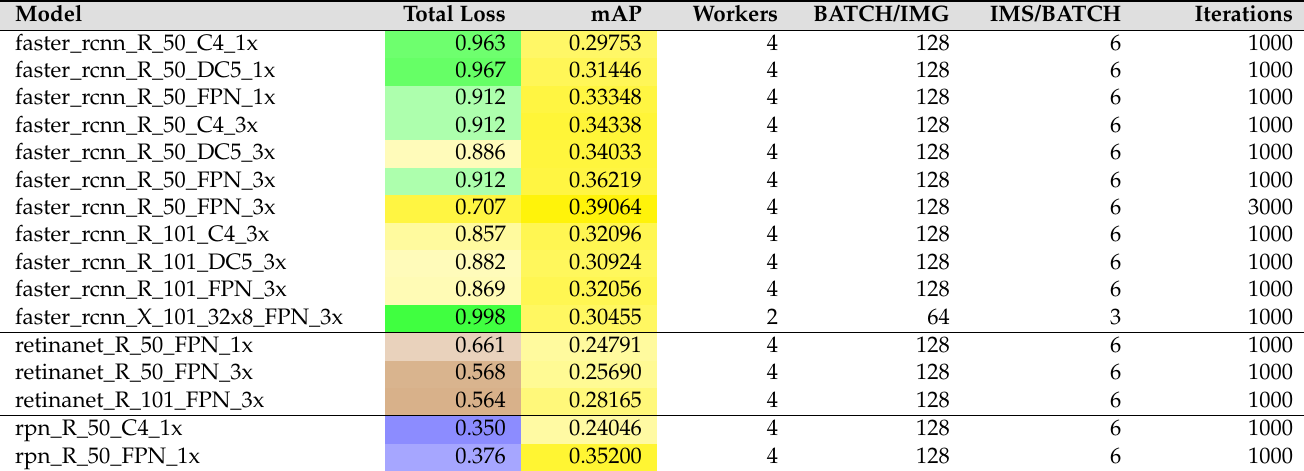
Table 2. Detectron Phase 2 Experiments and Results.